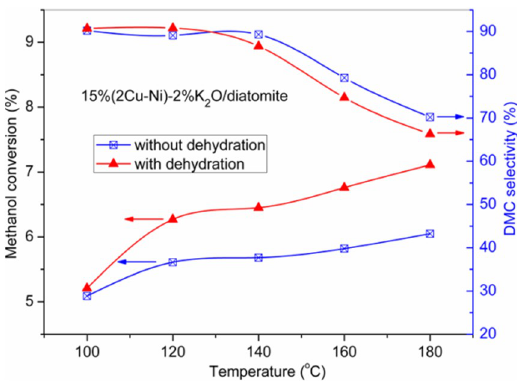
Figure 6. The effect of temperature on performance of catalyst with or without dehydration.